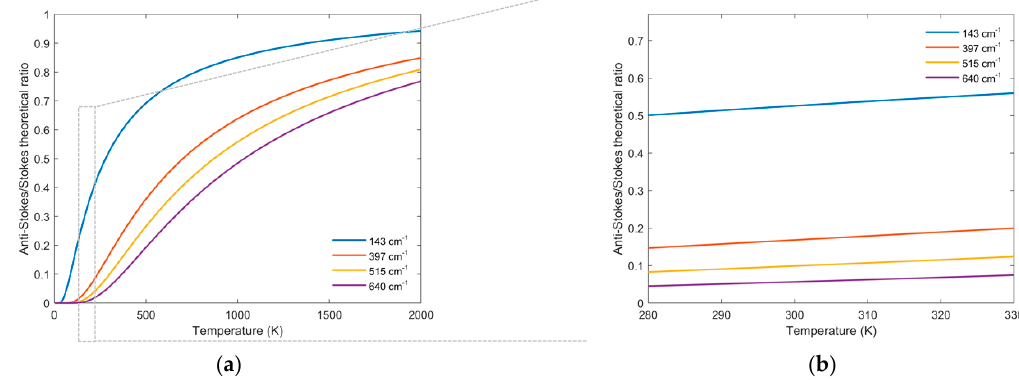
Figure A3. Theoretical anti-Stokes/Stokes ratio evaluated at λ exc = 514.5 nm, for all the four Raman modes of titanium dioxide, in a temperature range 0–2200 K ( a ) and in the range of interest ( b